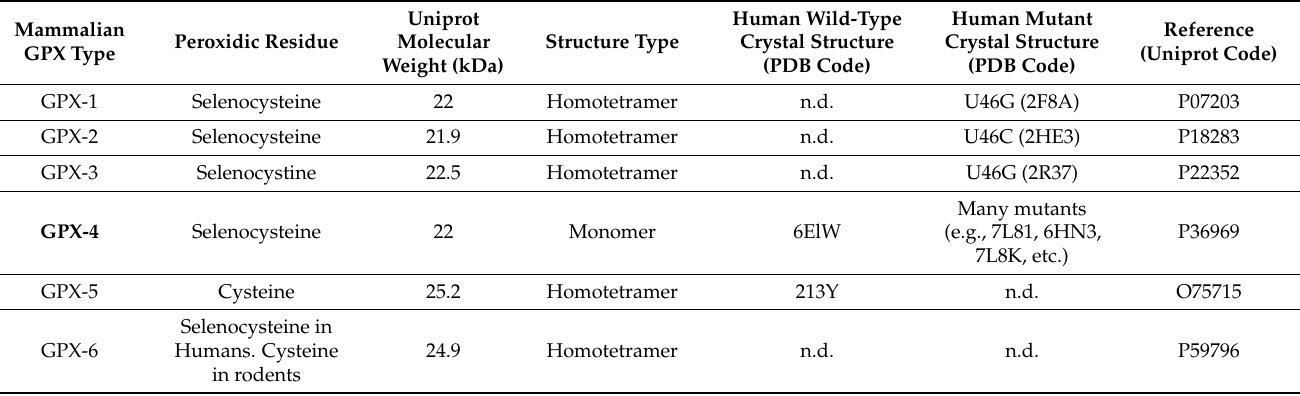
Table 2. Structural Features of Glutathione